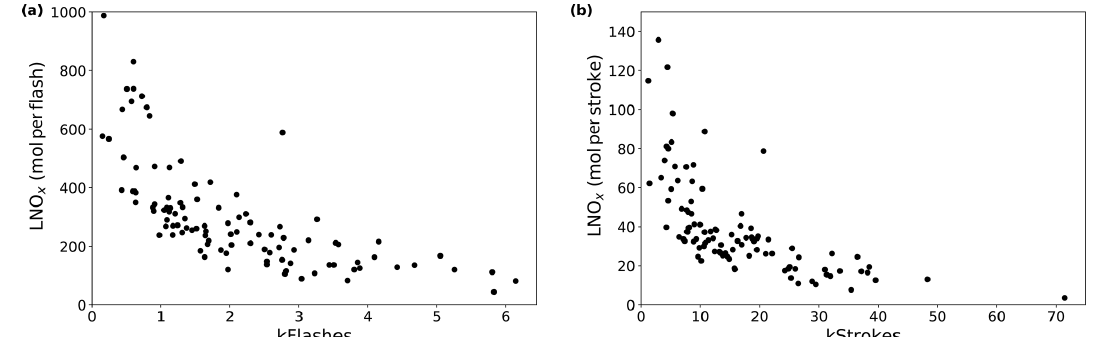
Figure B3. (a) Daily LNO x production efficiencies versus ENTLN total flash data, with CRF ≥ 90% and a flash threshold of one flash per box. (b) Same as (a) but for